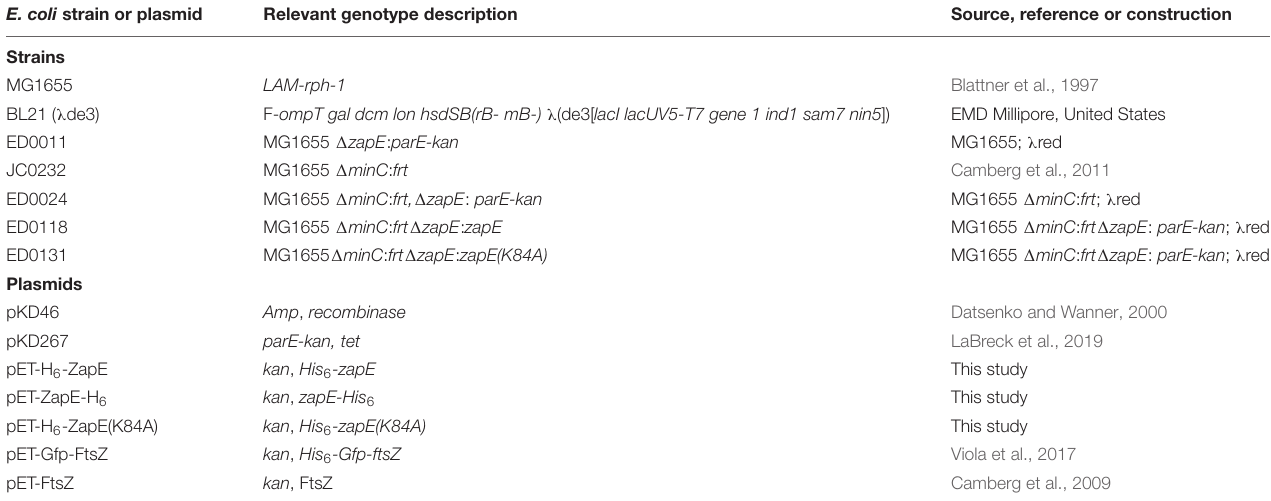
TABLE 1 | E. coli strains and plasmids used for genetic analyses and constructions in this